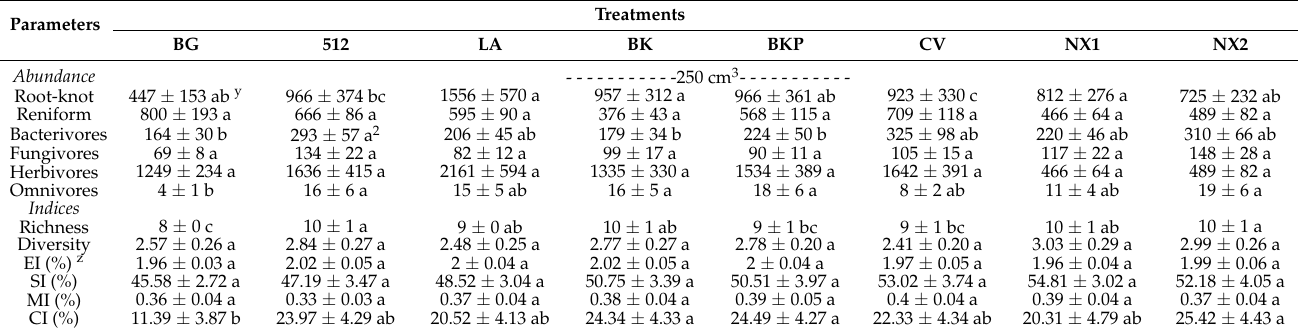
y Means ± standard error ( n = 28) are averaged from repeated measures over seven sampling dates. Values followed by the same letter(s) in a row are not different based on Waller–Duncan k -ratio ( k = 100) t -test. z EI = Enrichment index; SI = Structure index; MI = Maturity index; CI = Channel index.